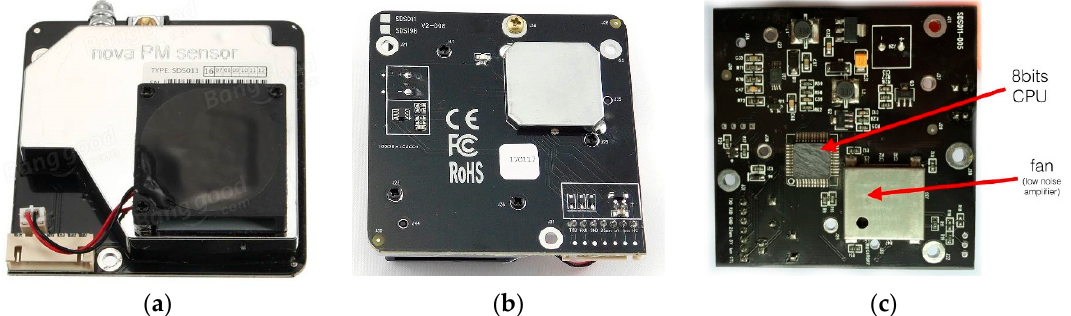
Figure 1. Nova PM (Particulate Matter) sensor SDS011: ( a ) sensor front; ( b ) sensor back; ( c ) sensor inside [17].